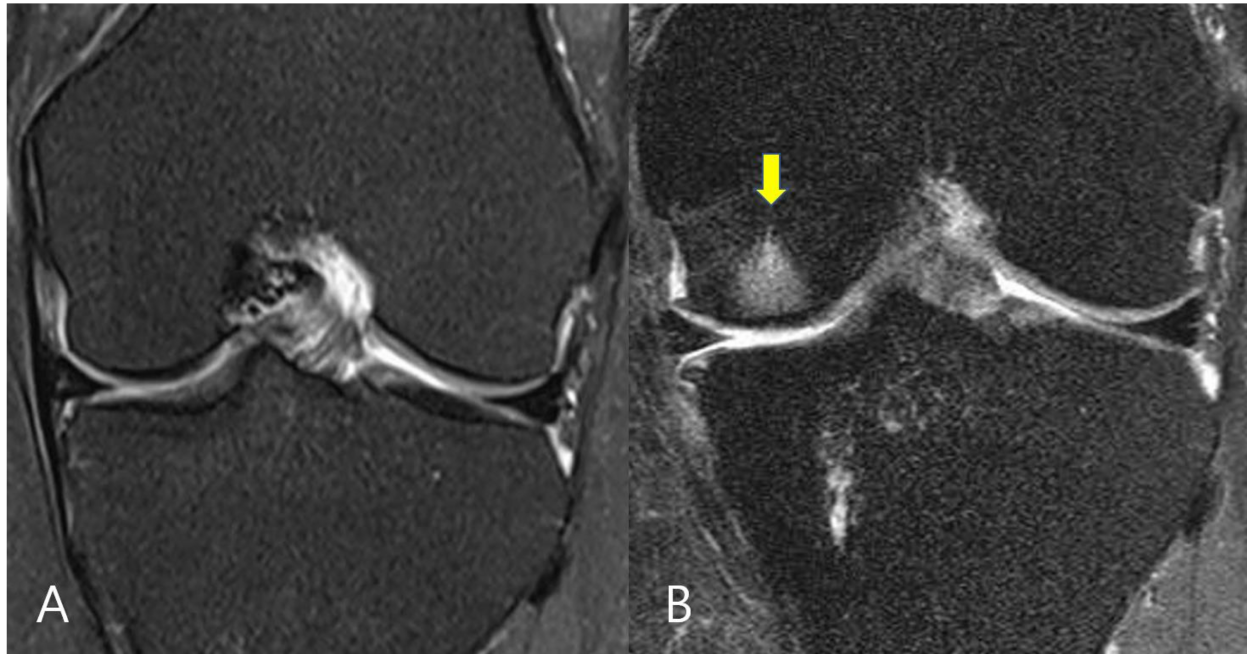
Figure 3. Magnetic resonance imaging (MRI) scans of a patient with a medial meniscus posterior root tear. ( A ) Pre-operative MRI view with no bone marrow edema lesion on the medial femoral condyle. ( B ) One-year follow-up MRI view showing a bone marrow edema lesion on the medial femoral condyle (yellow